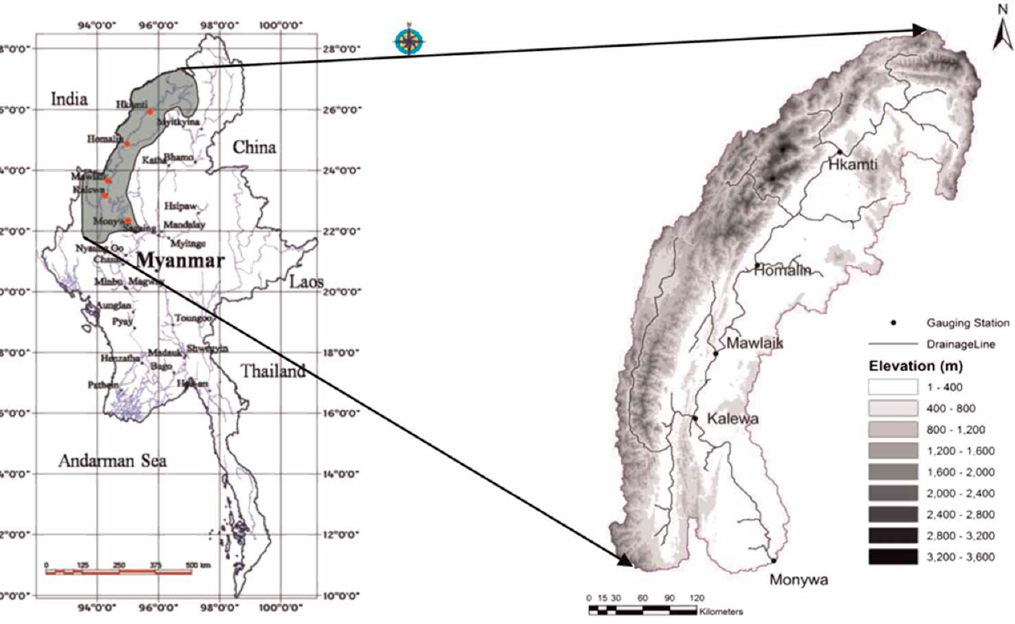
Water 2018 , 10 , x FOR PEER REVIEW Figure 6. The location of the River in Myanmar. Figure 6. The location of the River in Myanmar.